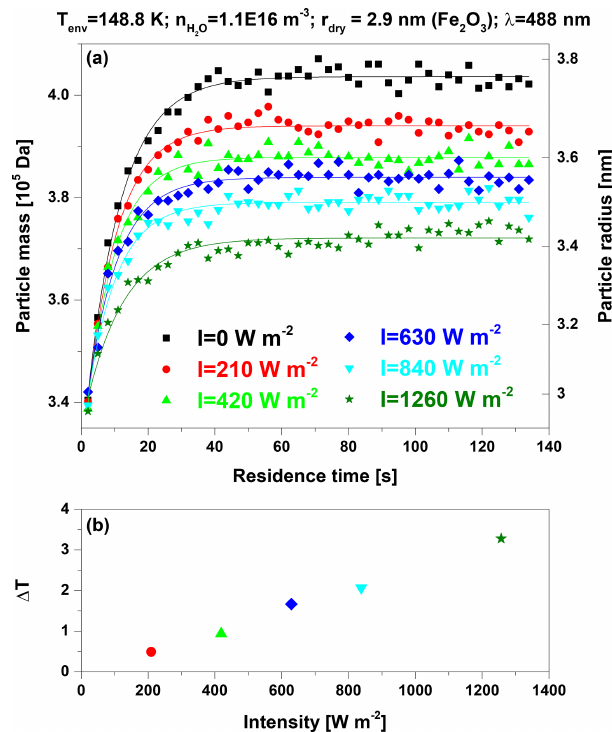
Figure 2. (a) Mean particle mass as a function of residence time in MICE for six different mean light intensities ( λ = 488nm, r dry = 2 . 9nm (Fe 2 O 3 ), T env = 148 . 8K, n H The solid curves represent fits of Eq. (2) to the data. (b) Particle temperature offsets (cid:49)T (Eq. 4) as a function of the mean light in-